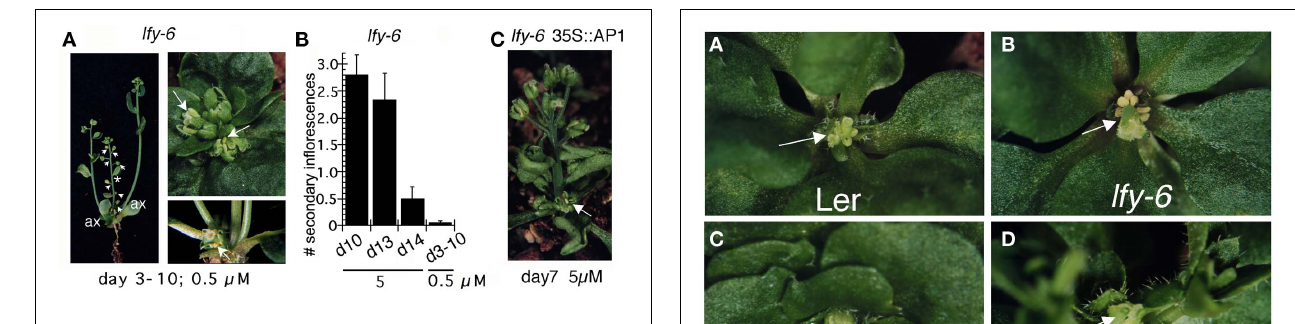
FIGURE 5 | Effect of prolonged LFY activation of meristem identity. Seedlings were treated for 7days daily starting at day 3 with 0.5 μ M dexamethasone. Phenotypes of all plants were observed at maturity. (A) Left panel. A mature lfy-6 LFY-GR plant. Many axillary and all secondary inflorescences have been converted into flowers. One of these flowers still has some inflorescence traits and is subtended by a bract (asterisk). Many axillary inflorescences produce rescued, fertile flowers (data not shown). Later formed axillary meristems produce lfy-6 -like inflorescences (ax). Right panel top. Secondary inflorescences in a lfy-6 LFY-GR plant were converted to single flowers subtended by a cauline leaves.These flowers are partially rescued because petaloid (arrow) and stamenoid organs are formed. Right panel bottom. A flower with stamens formed instead of an axillary inflorescence in a lfy-6 LFY-GR plant (arrow). (B) Plants treated at day 10, day 13, and day 14 by a single 2h 5 μ M dexamethasone application were compared to plants treated for 7days with 0.5 μ M dexamethasone starting at day 3.The number of inflorescences above the last inflorescence converted to a flower were counted for at least 20 plants per treatment day. (C) A lfy-6 LFY-GR plant in a weak 35S<AP1 background. Plants were treated once at day 7 with 5 μ M dexamethasone as described in Figure 1 . The arrowhead points to a partially rescued flower.